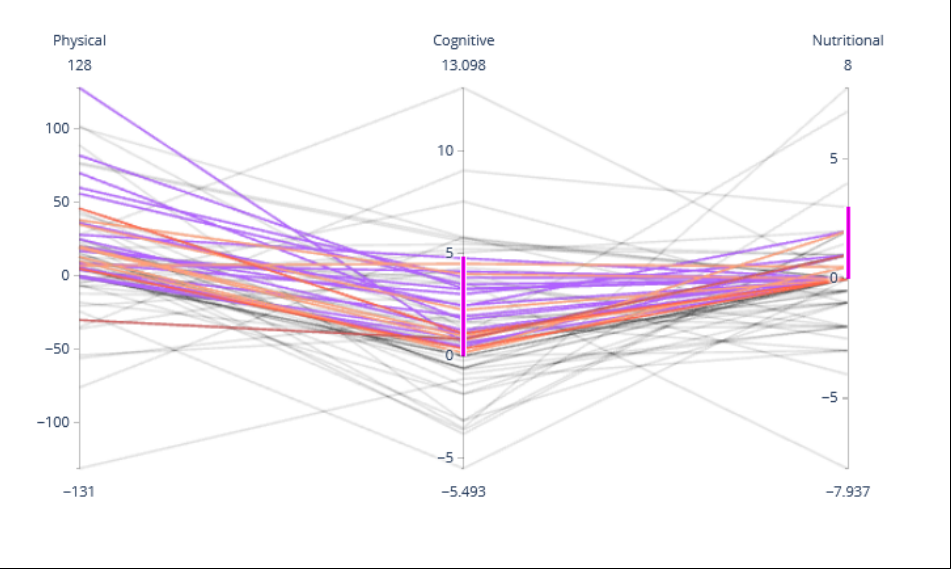
Figure 6. Changes in each field per participant shown in a parallel coordinate, determined by the color of the cluster the participant belongs to.